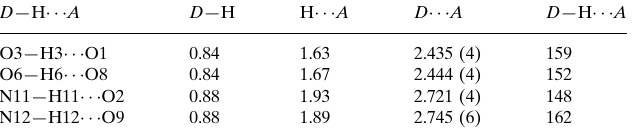
Hydrogen-bond geometry (A ˚ , (cid:4)